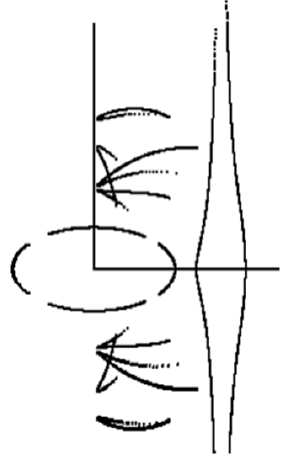
Figure 21. q = − 2, KG = 100, and DK = 100.